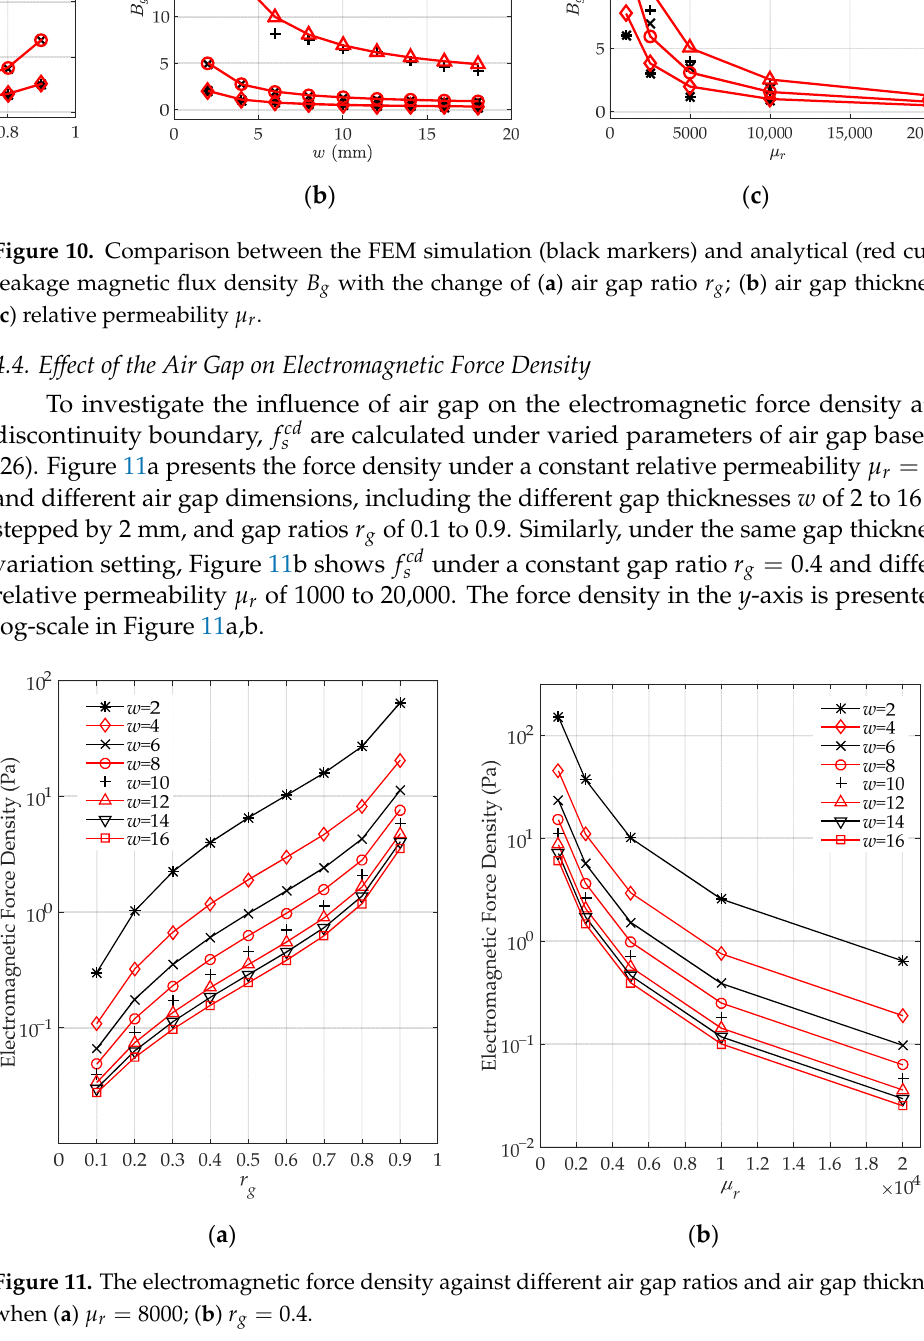
r ; ( b ) air gap thickness w g